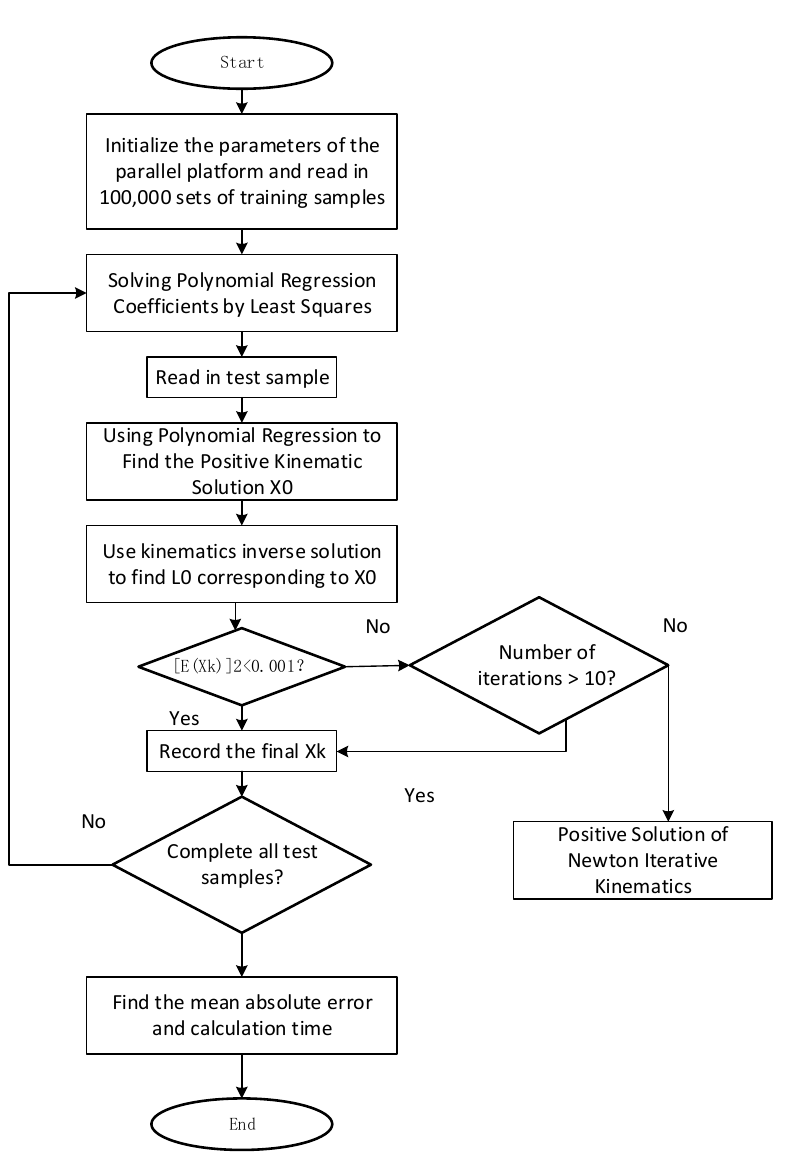
Figure 4. MPR-NR algorithm flowchart.